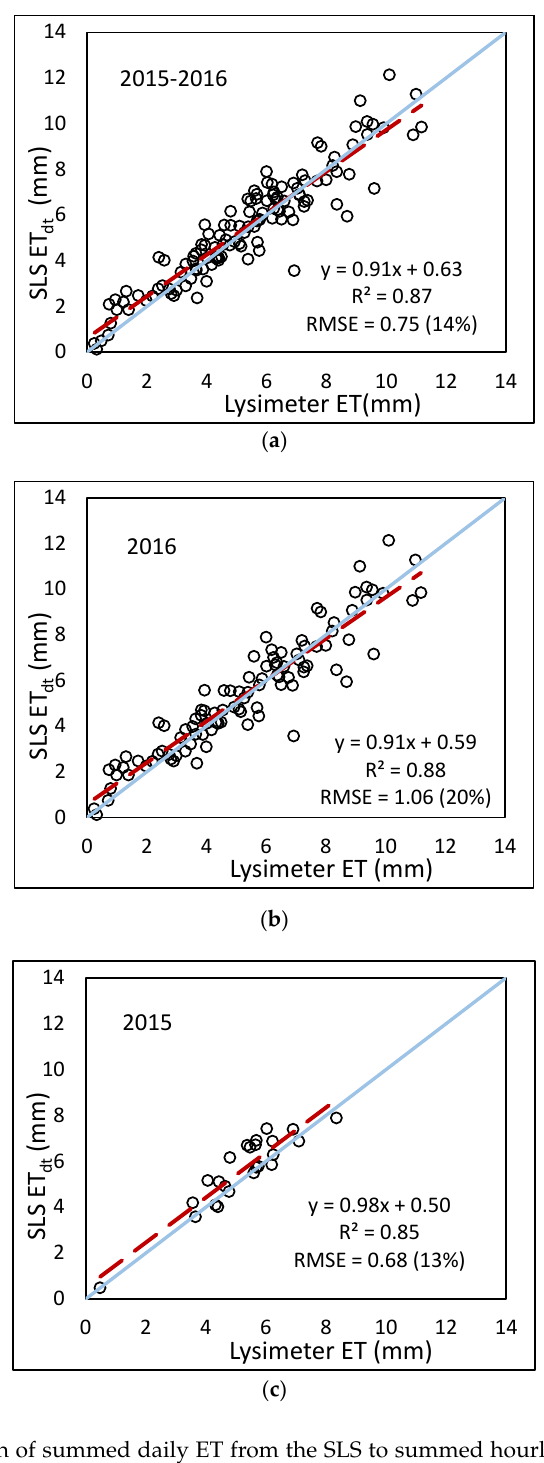
Figure 11. Comparison of summed daily ET from the SLS to summed hourly lysimeter data using ( a ) combined 2015-2016 data; ( b ) 2016 only; ( c ) 2015 only.